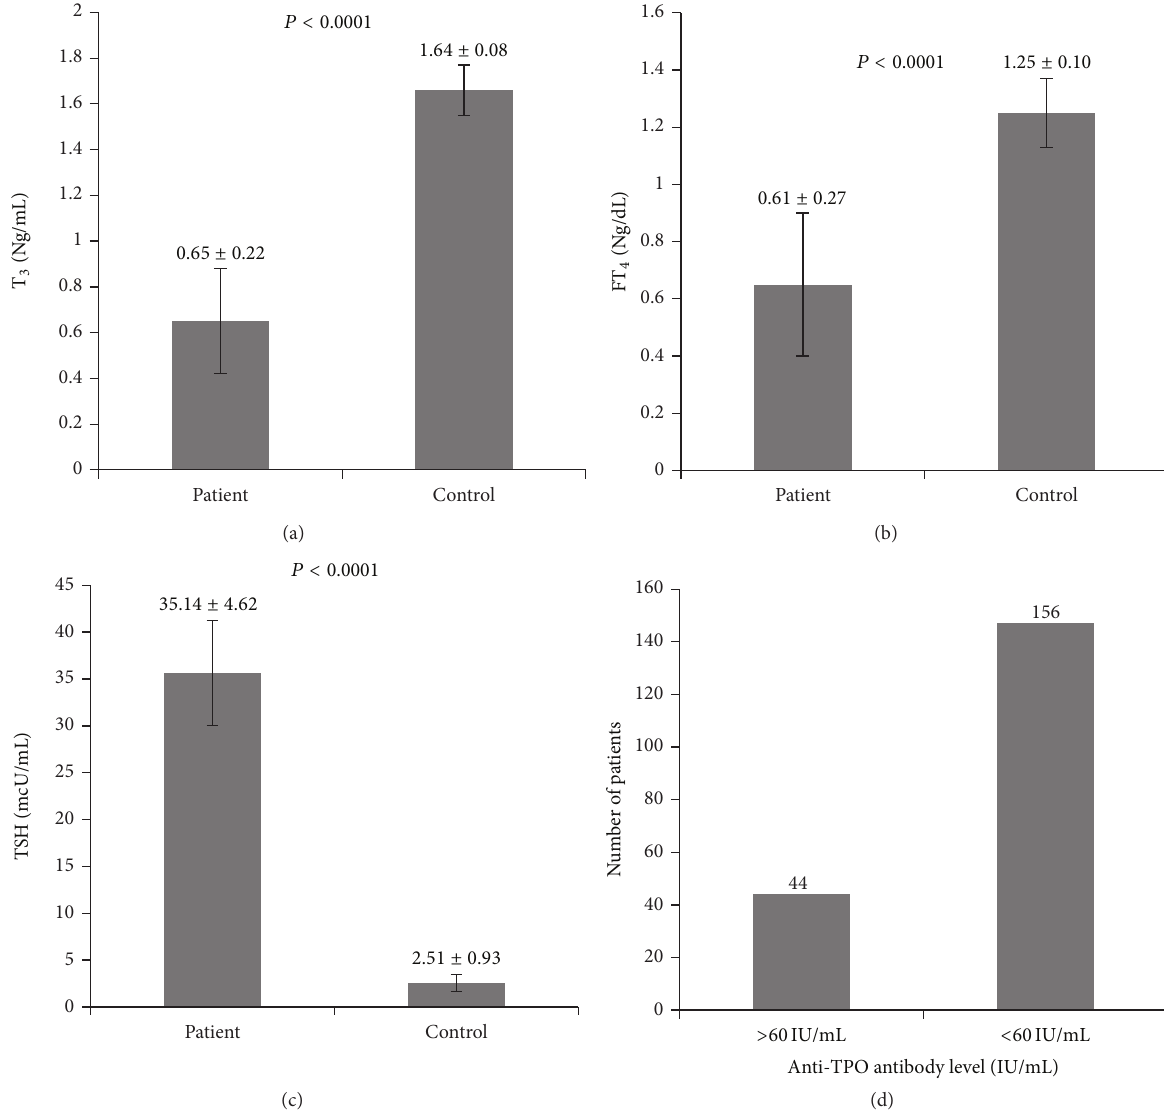
Figure 1: T 3 and FT 4 level of patient and control (normal) populations. TSH and anti-TPO antibody level of patient and control (normal)